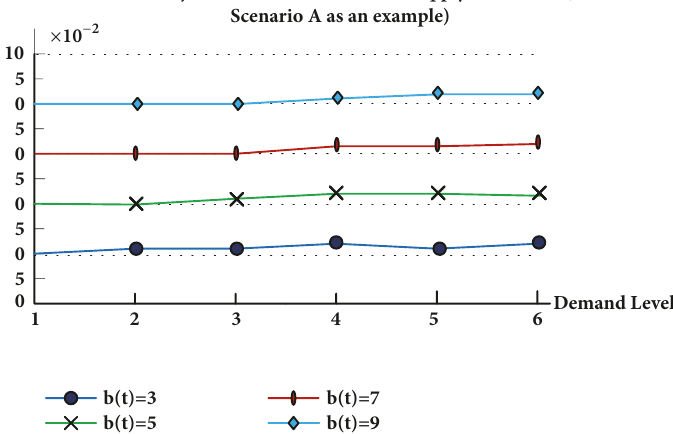
Figure 5: Operational performance under Scenario A in terms of social injustice index.